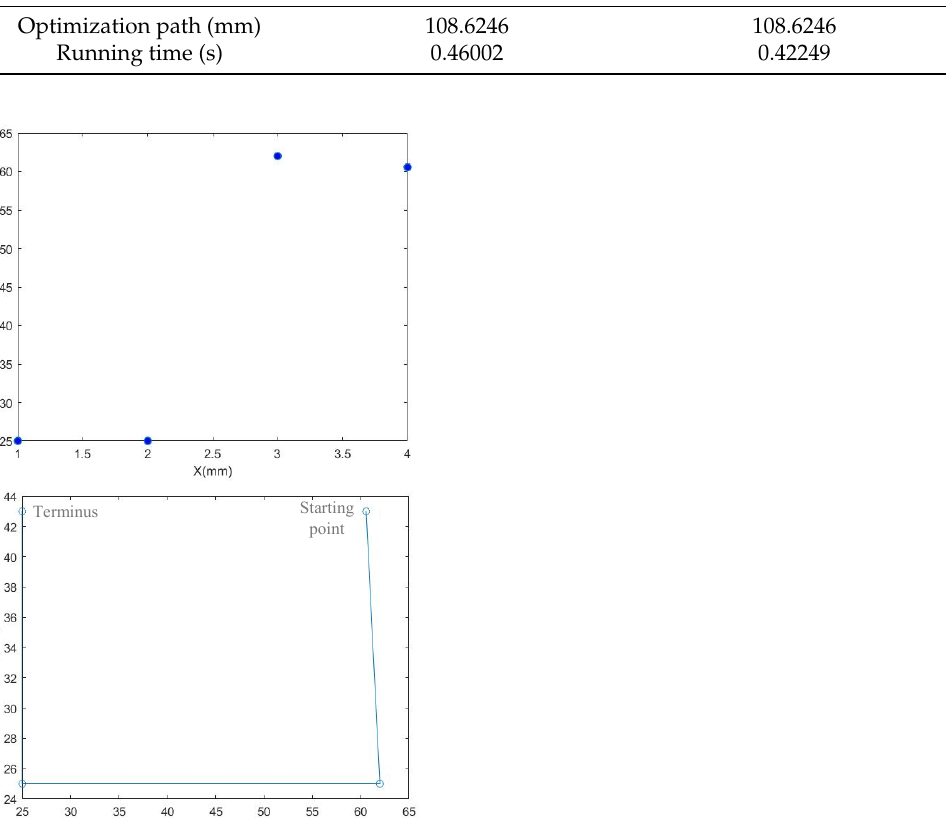
Table 6. Comparison of moving path optimization algorithms between processing frames. Ant Colony Algorithm Mixed Algorithm